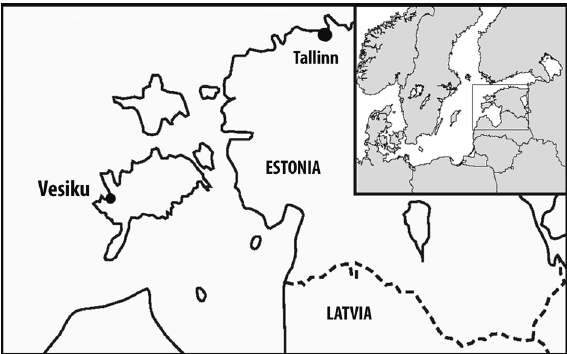
Fig. 1. Location of the Vesiku Brook outcrop, Saaremaa Island, Estonia. Modified from M(cid:228)rss & M(cid:228)nnik